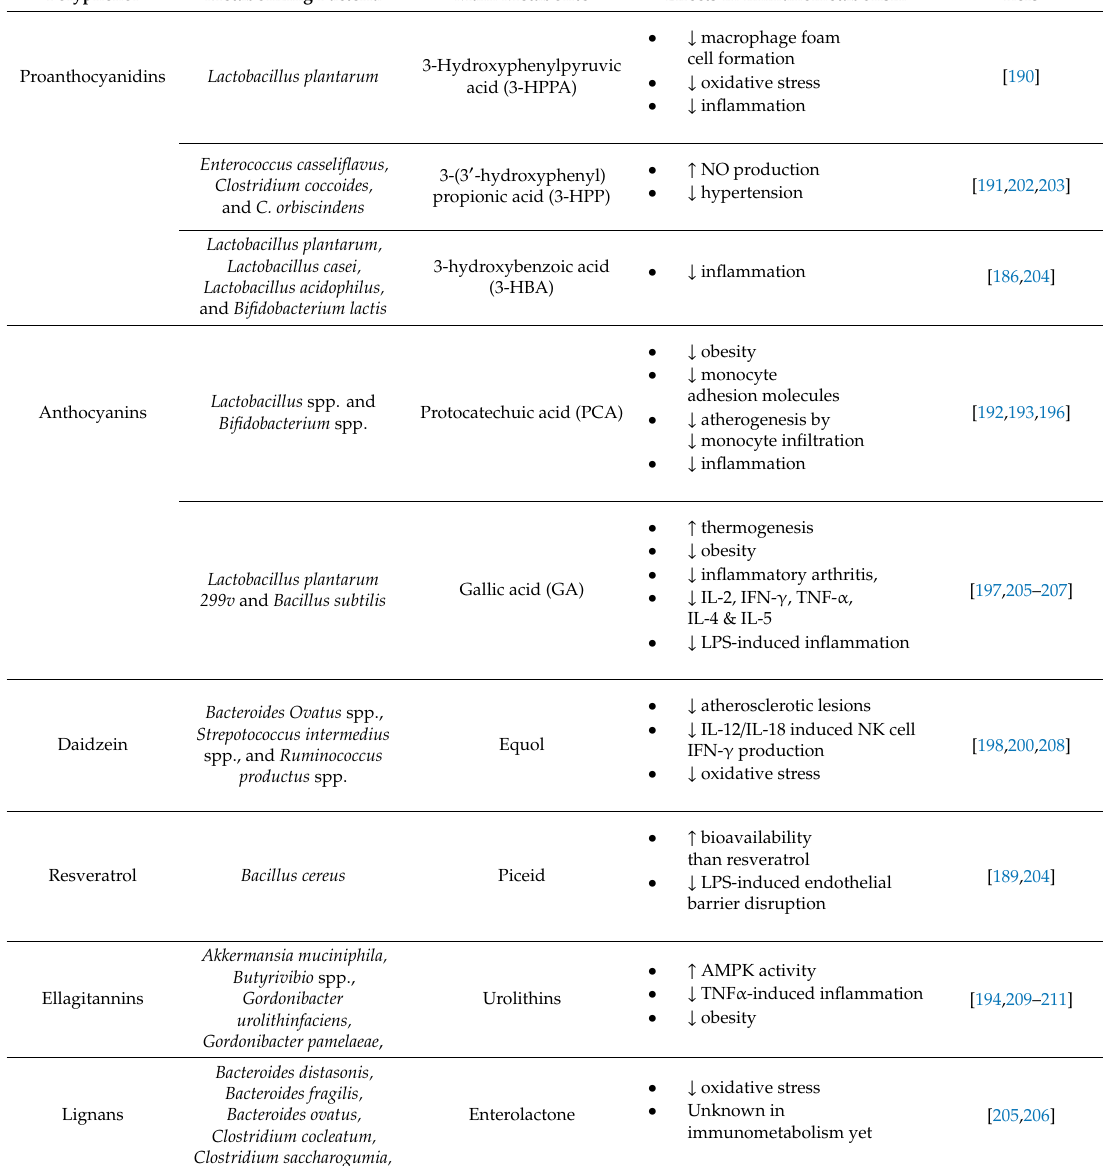
Table 1. Microbial-derived polyphenolic metabolites and their protective e ff